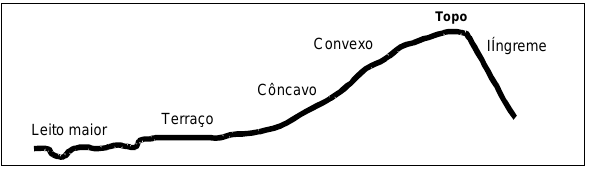
Figura 2. Esquema da conformação típica das vertentes no Planalto de Viçosa. Fonte: Rezende (1971).